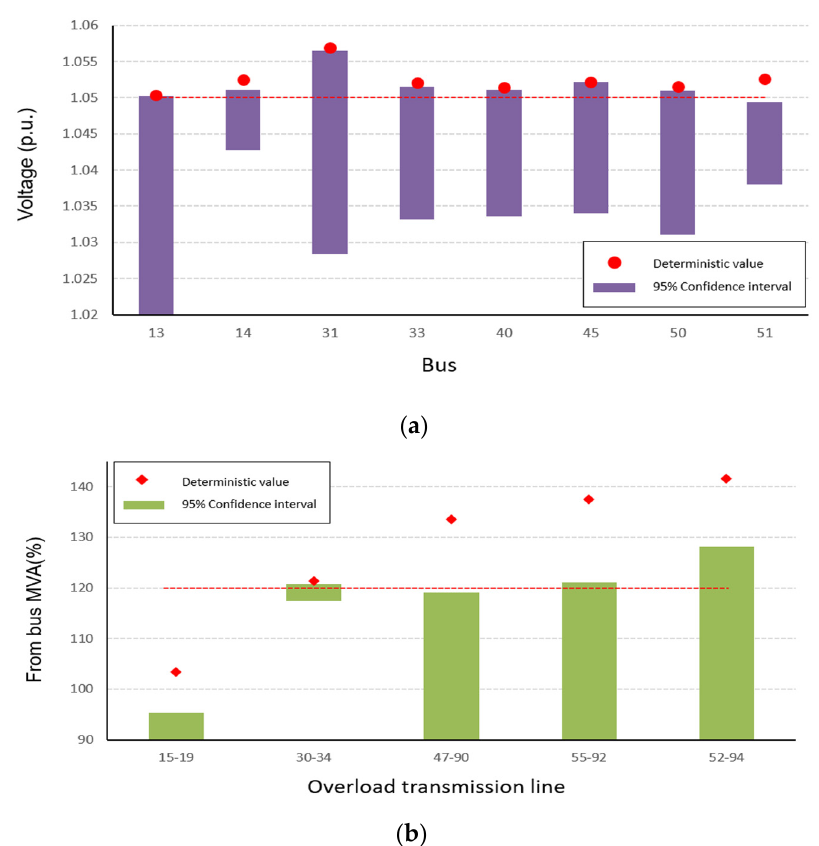
Figure 6. Comparison of the post N-1 contingency results based on the probabilistic and deterministic methods: ( a ) voltage of the buses where a voltage violation occurred; and ( b ) the overload rate of transmission lines where the overload occurred.